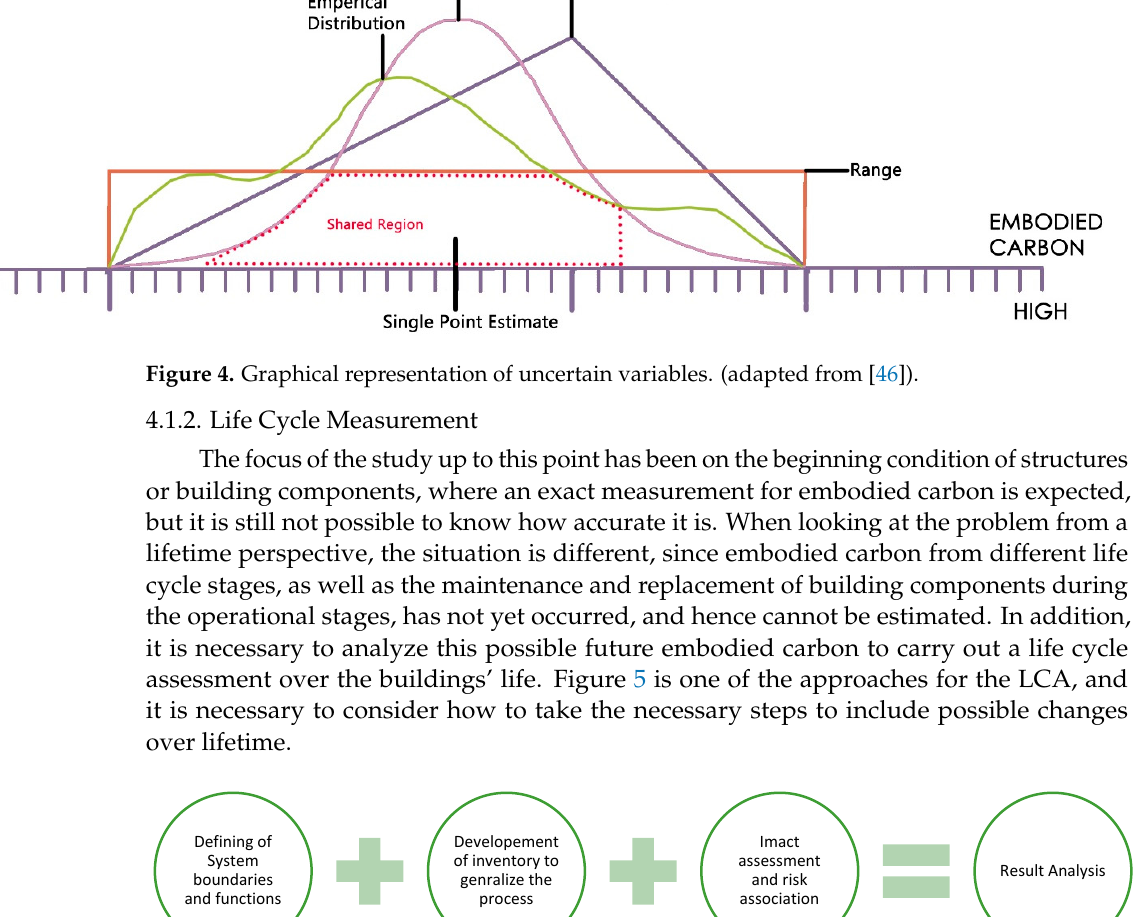
9 of 22 Figure 3. Probabilistic approaches for embodied carbon assessment. •